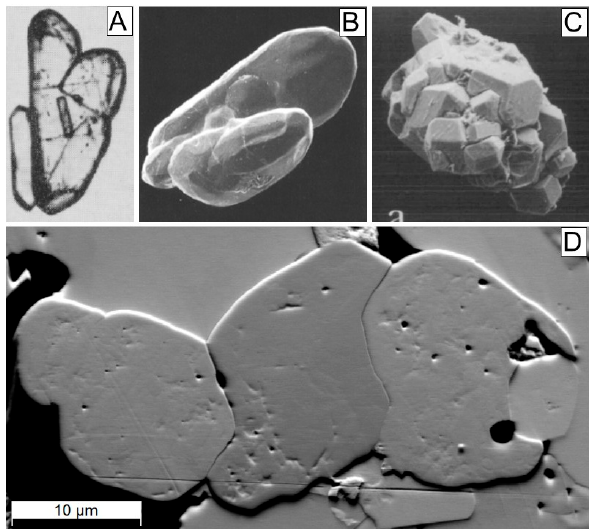
Figure 13. Examples of polycrystalline zircon from felsic magmatic settings. ( A ) Optical microscopy image after [7]. Twinned grain recovered from Precambrian granite gneisses from SW Greenland. ( B ) SEM image after [8]. Aggregate extracted from the metamorphosed trondhjemite from Massif Central, S France. ( C ) SEM image after [9]. Polycrystalline zircon aggregate was derived from the Suzhou granite pluton, E China. ( D ) Orientation contrast image of a chain of four zircon grains, after [11]. Grains are observed in situ in aplite dike, Western Tauern Window, S Austria.